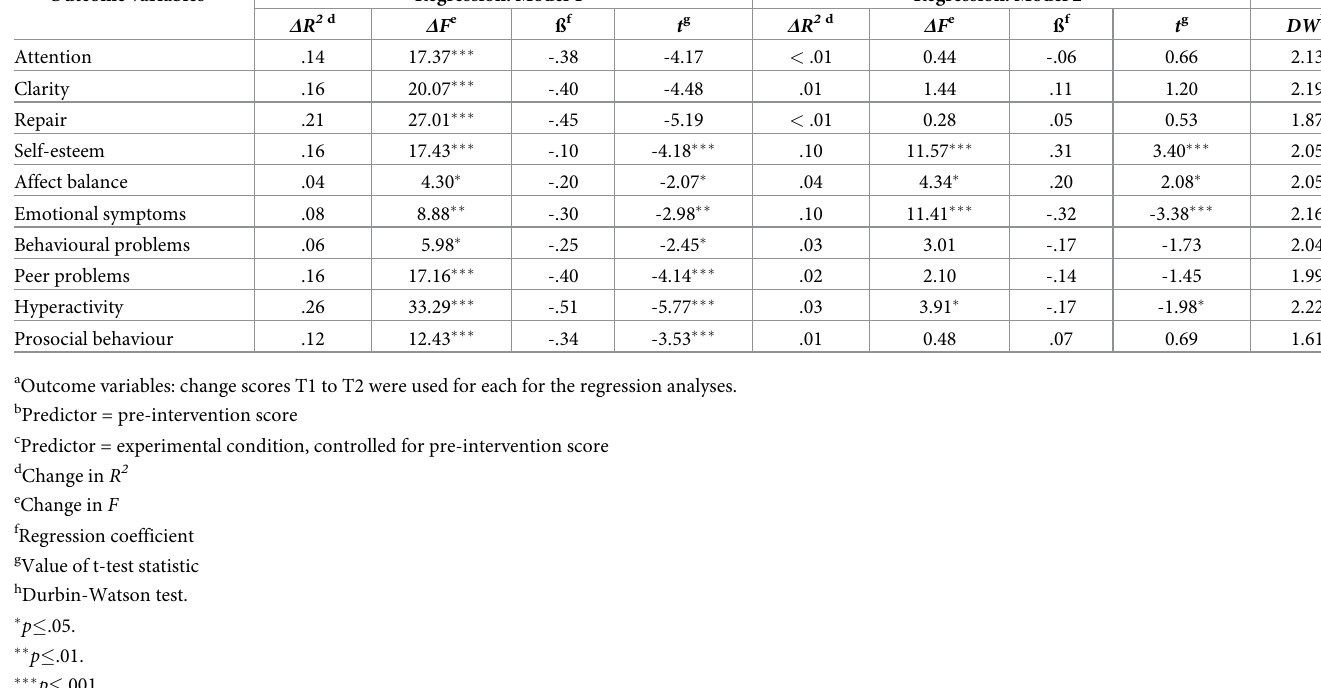
Table 4. Hierarchical multiple regression analyses. Outcome variables a Regression: Model 1 b Regression: Model 2 c